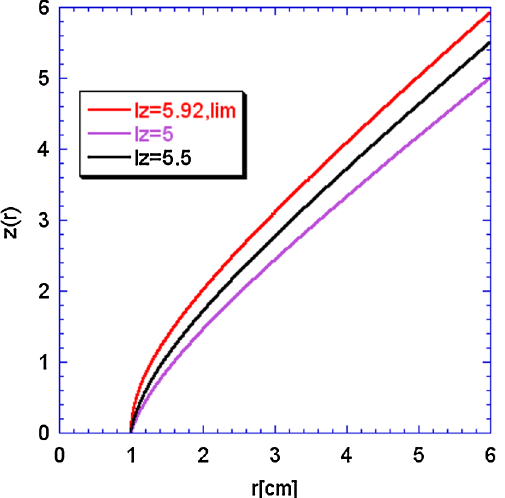
FIG. 5. (Color) Optimal z ð r Þ for our solution for case (v) in < 0 . It shows the midgap curves for three optimal Sec. II, i.e. w 0 ¼ 1 cm , TL, all of them having the same inner point and gap r 1 z ¼ 0 cm , and w ¼ 0 : 4 cm . The outer end point radius and 1 1 ¼ 6 cm , w ¼ 3 : 6 cm , corresponding to gap are also fixed at r 2 2 w ¼ (cid:1) 0 : 24 cm The outer point axial position is varied from 0 z ¼ 5 cm to z ¼ 5 : 92 cm . This latter value for the axial 2 lim . A higher value of the axial position is such that z 0 ! 1 , r ¼ r 1 , position is not attainable without going to radii smaller than r 1 but this would violate the constraint of not allowing any curve going through radii smaller than that of the inner